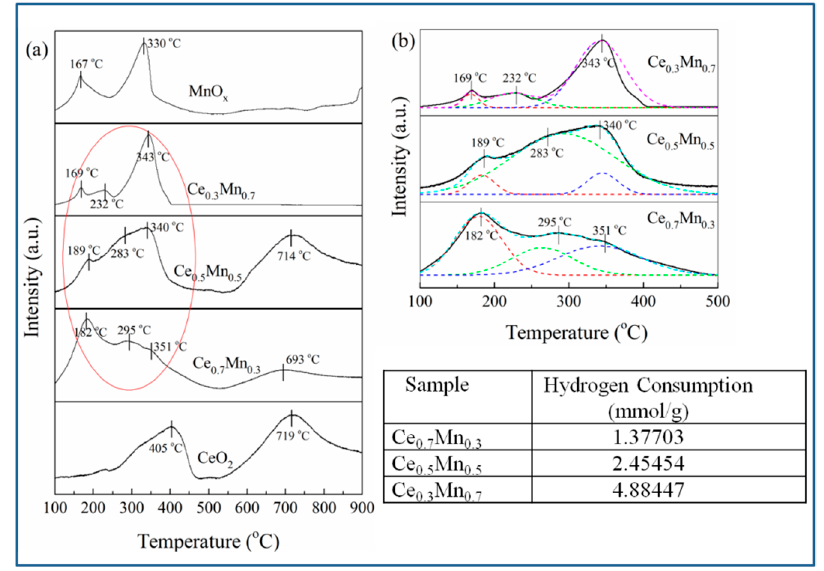
Figure 5. H 2 -TPR of CeO 2 , MnO x , Ce x Mn 1 − x ( a ) and Enlarged picture of the red circle area ( b ).